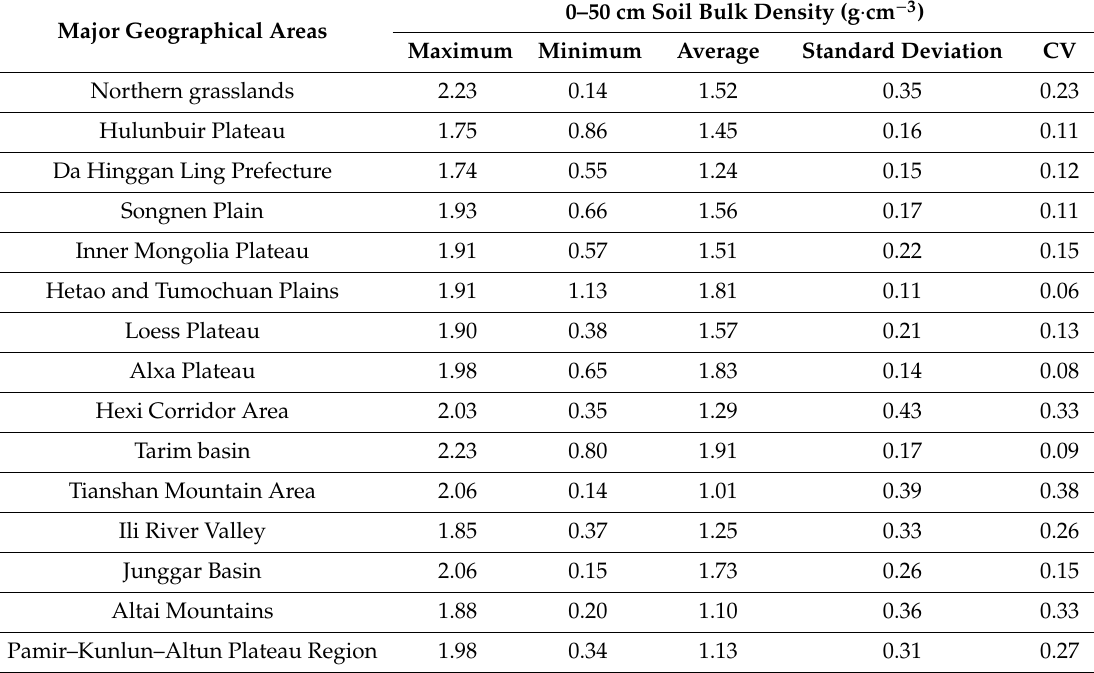
Table 2. Statistical analysis in di ff erent geographical regions.